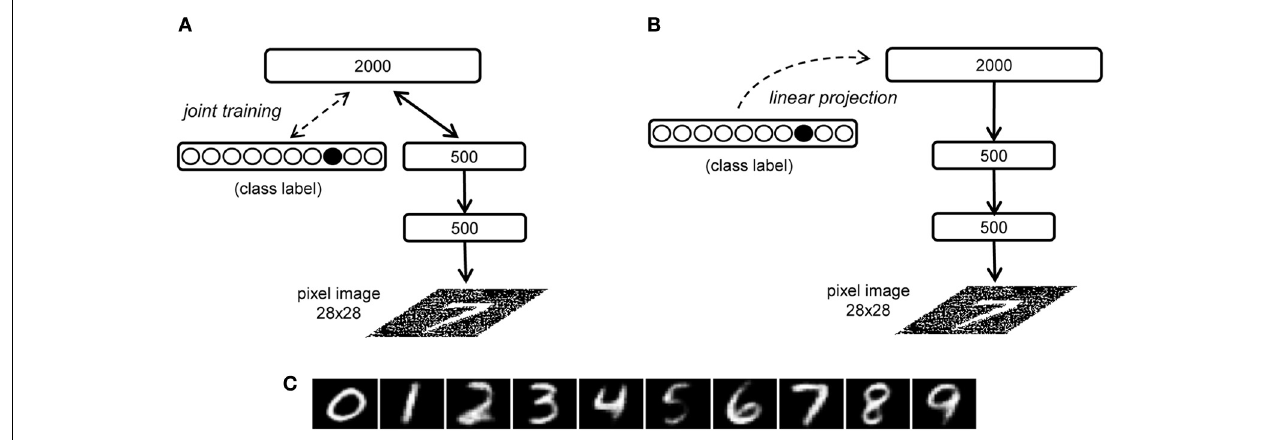
FIGURE 8 | Illustration of the prototype generation methods in the handwritten digit recognition model. (A) The RBM involving the third hidden layer is jointly trained on the internal representation of the second hidden layer and an additional set of units representing the digit classes